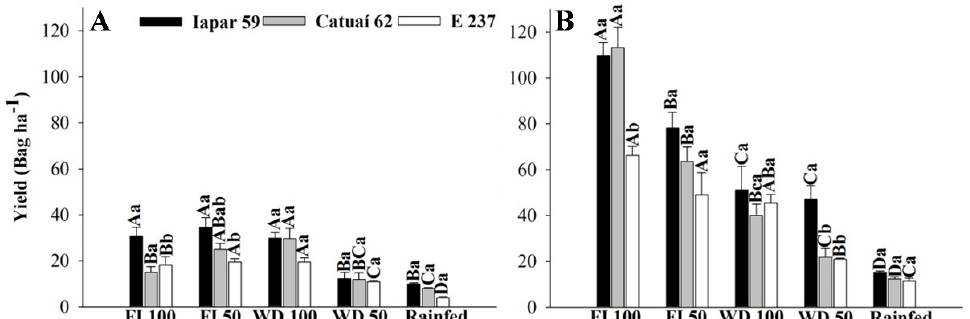
Figure 7. Productivity (bag ha −1 ) of three arabica coffee genotypes (E237, Iapar 59 and Catuaí 62) under five water regimes (FI 100, FI 50, WD 100, WD 50 and rainfed), in 2019 ( A ) and 2020 ( B ). Capital letters compare the water regimes for each cultivar and lowercase letters compare the culti- vars of each water regime. Means followed by the same letter do not differ according to the Tukey test at 5% probability. FI 100 and 50 (full irrigation with 100% and 50% replacement of evapotran- spiration); WD 100 and 50 (water deficit with the suspension of irrigation from June to September, with replacement of 100% and 50% of evapotranspiration, respectively); rainfed (without irrigation). Bag = 60